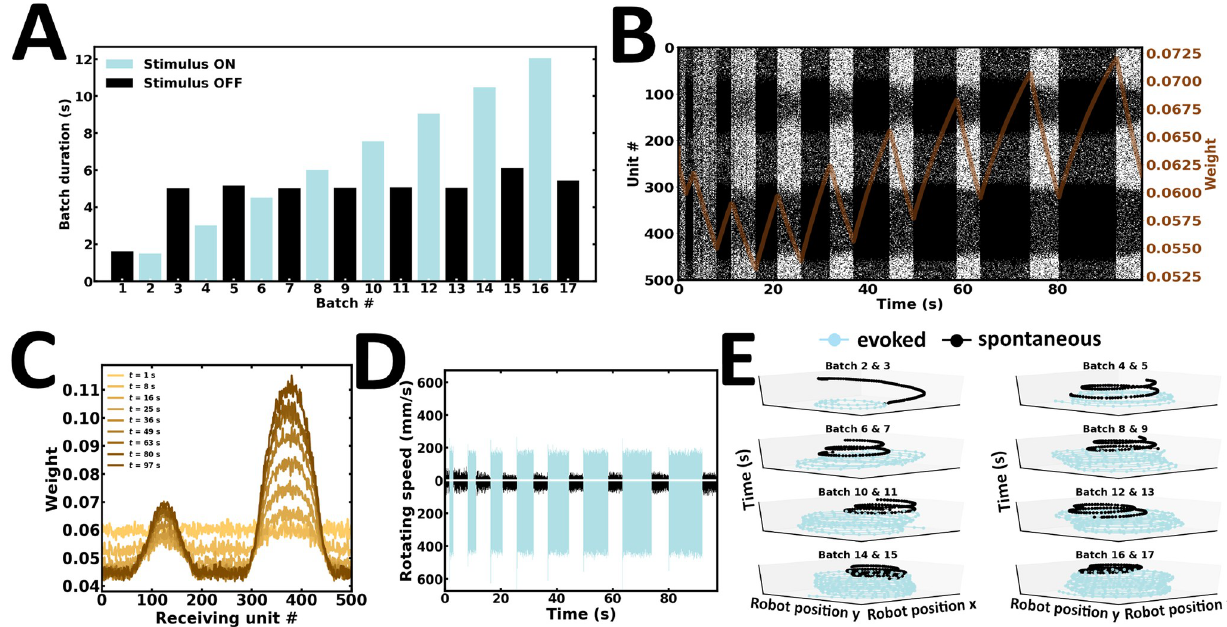
Fig 9. Incremental learning and recall. (A) Duration of evoked and spontaneous batches. (B) Raster plot of network activity. Persistent activity gain depends on stimulus duration; brown curve, average synaptic efficacy. (C) Evolution of average incoming synaptic weights at the end of spontaneous batches. (D) Rotating speed of left and right wheel motors as a function of time. (E) Motor trajectory of the robot in 3-D space during subsequent pairs of evoked and spontaneous batches.